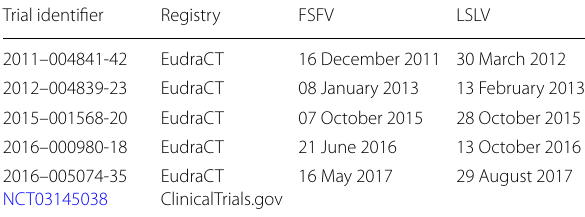
Additional file 1: Table S1. Vericiguat formulations administered within the clinical development program. Table S2 . HPLC conditions for determination of vericiguat content in filtrate in dissolution studies. Table S3. Dissolution of vericiguat 10 mg as an intact tablet, crushed tablet suspension immediately after preparation, and as a crushed tablet suspension 4 h after preparation in 900 mL 0.01M HCl pH 2 at 37°C at 75 rpm. Table S4. Dissolution of vericiguat 10 mg as an intact tablet, crushed tablet suspension immediately after preparation, and as a crushed tablet suspension 4 h after preparation in 900 mL acetate buffer pH 4.5 at 37°C at 75 rpm. Table S5. Dissolution of vericiguat 10 mg as an